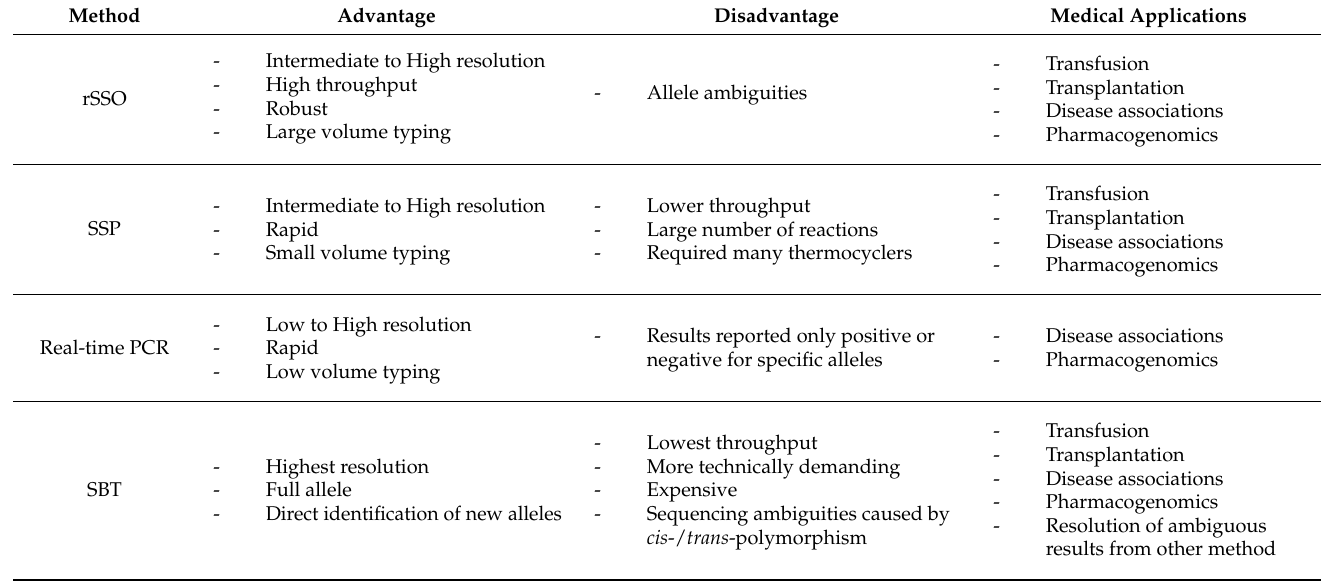
Table 1. Comparison of the common molecular HLA genotyping